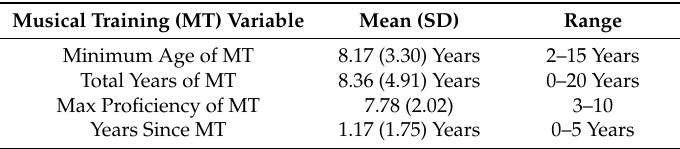
Table 5. Descriptive statistics of music training (MT) variables. Means and standard deviations (SD) in parenthesis for the minimum age of musical training, total years of musical training on primary instrument, self-rated maximum proficiency, and the number of years since musical